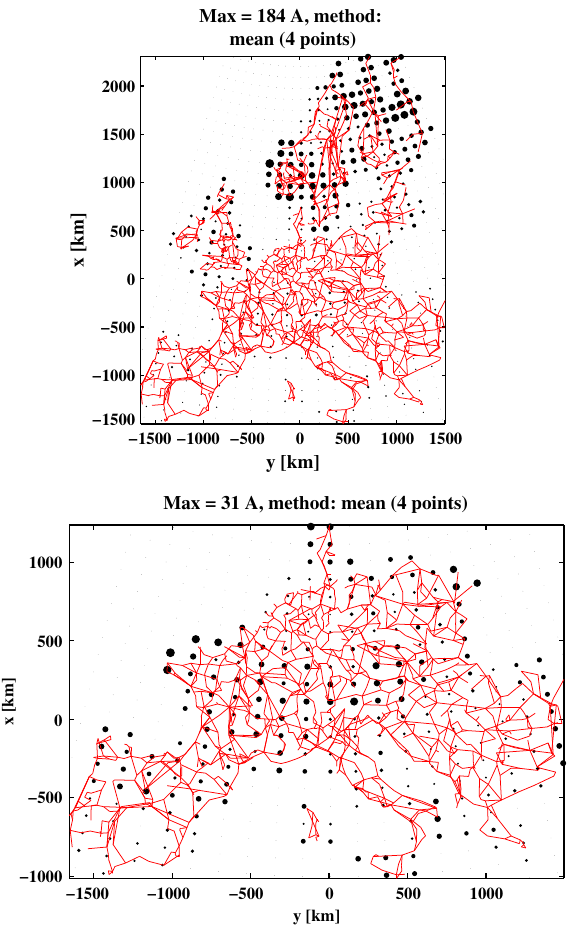
Fig. 5. Top: regionally averaged maximum of the modelled GIC at the substations of the European high-voltage power grid in 1996– 2008. Bottom: separate presentation for Central and South Europe. For clarity, the scales are different in the figures. Table 2. Maximum GIC A (top 1), the 10th largest maximum (top 10), average of the maximum GIC and median of the maximum GIC at the substations in different parts of the European high-voltage power grid. Continent refers to South and Central